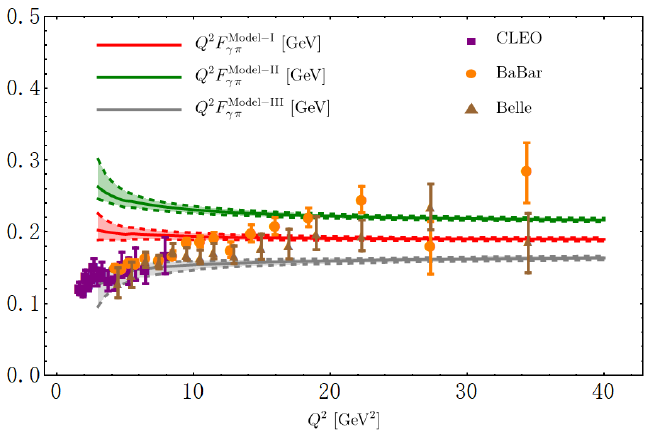
Figure 5: Theory predictions of the TFF γγ ∗ → π 0 based on the three models in (20). The color bands indicate uncertainties from factorization / renormalization scale vari- ∈ [ 1 / 4,3 / 4 ] Q 2 . For a comparison, our predictions are confronted with the ation µ F experimental measurements from the CLEO [ 1 ] (purple squares), BaBar [ 2 ] (orange circles) and Belle [ 3 ] (brown spades)